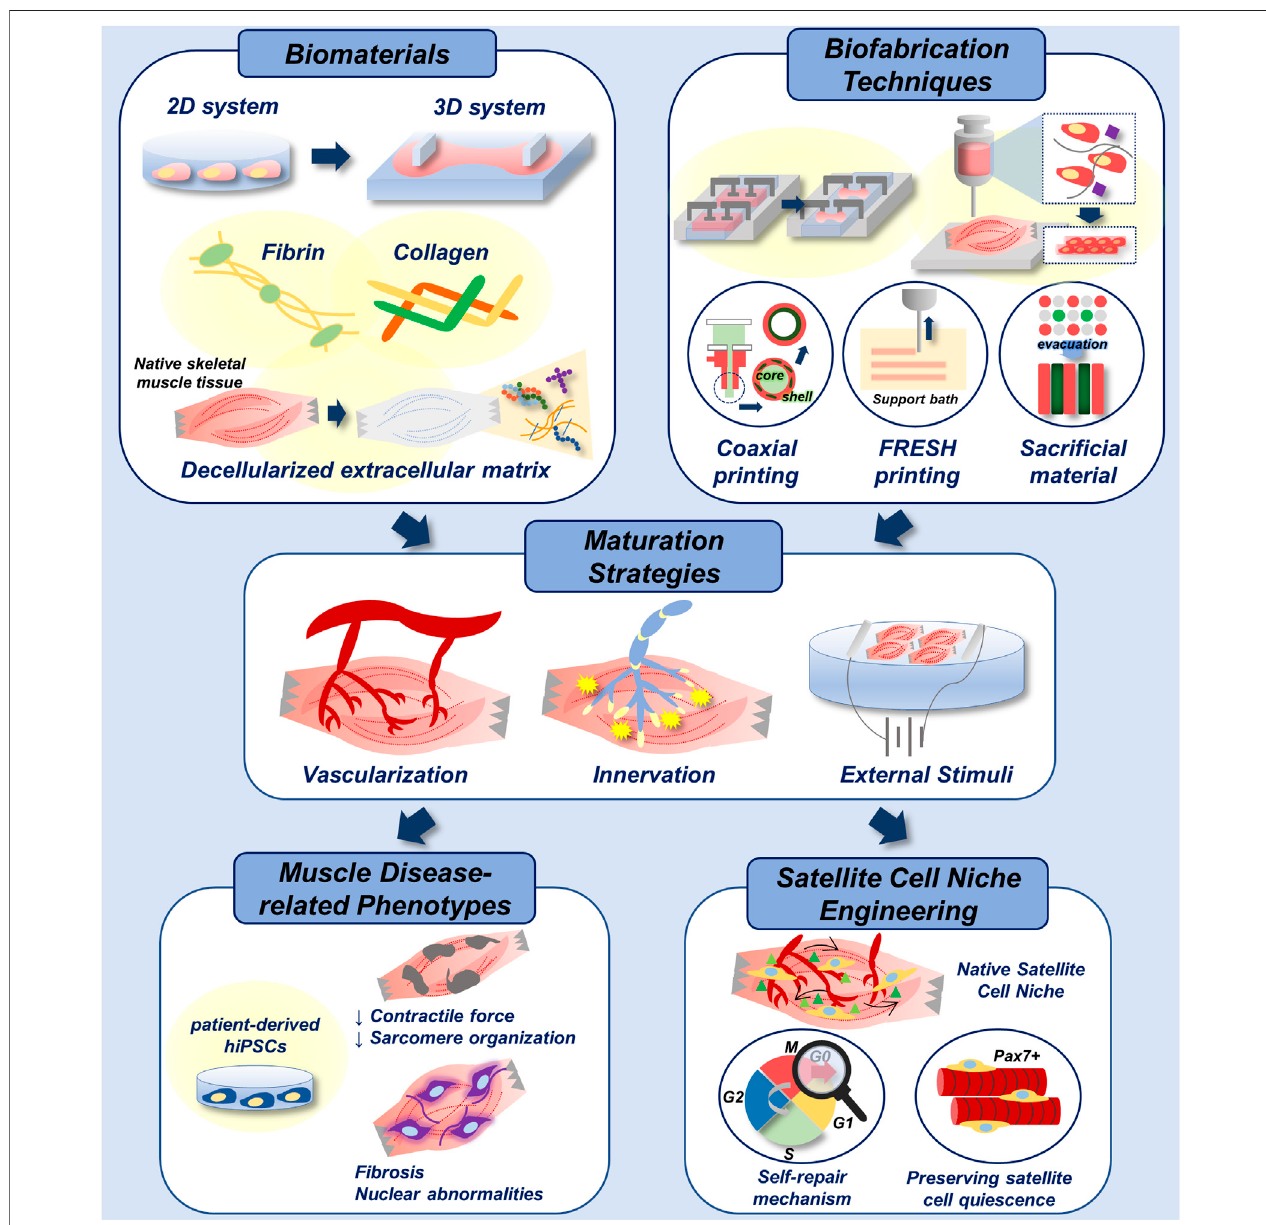
FIGURE6| Biofabricationofskeletalmusclediseasemodels.Multiplebiomaterialsandbiofabricationtechniquescanbeutilizedtodevelop 3D-engineered muscle withnativetissue-likestiffnessand topography (top).Functionalmaturation of3D-engineered tissueisachievedbyvascularization,innervation and electrical/mechanical stimuli (middle). With the incorporation of patient-derived hiPSCs, addressed biofabrication techniques can be applied in recapitulation of muscle disease-related phenotypes in vitro. In addition, they could be applied in engineering of native satellite cell niche for the study of muscle self-repair mechanism, and for the preservation of satellite cell quiescence in vitro , which enhances the therapeutic ef fi cacy of cells (bottom).